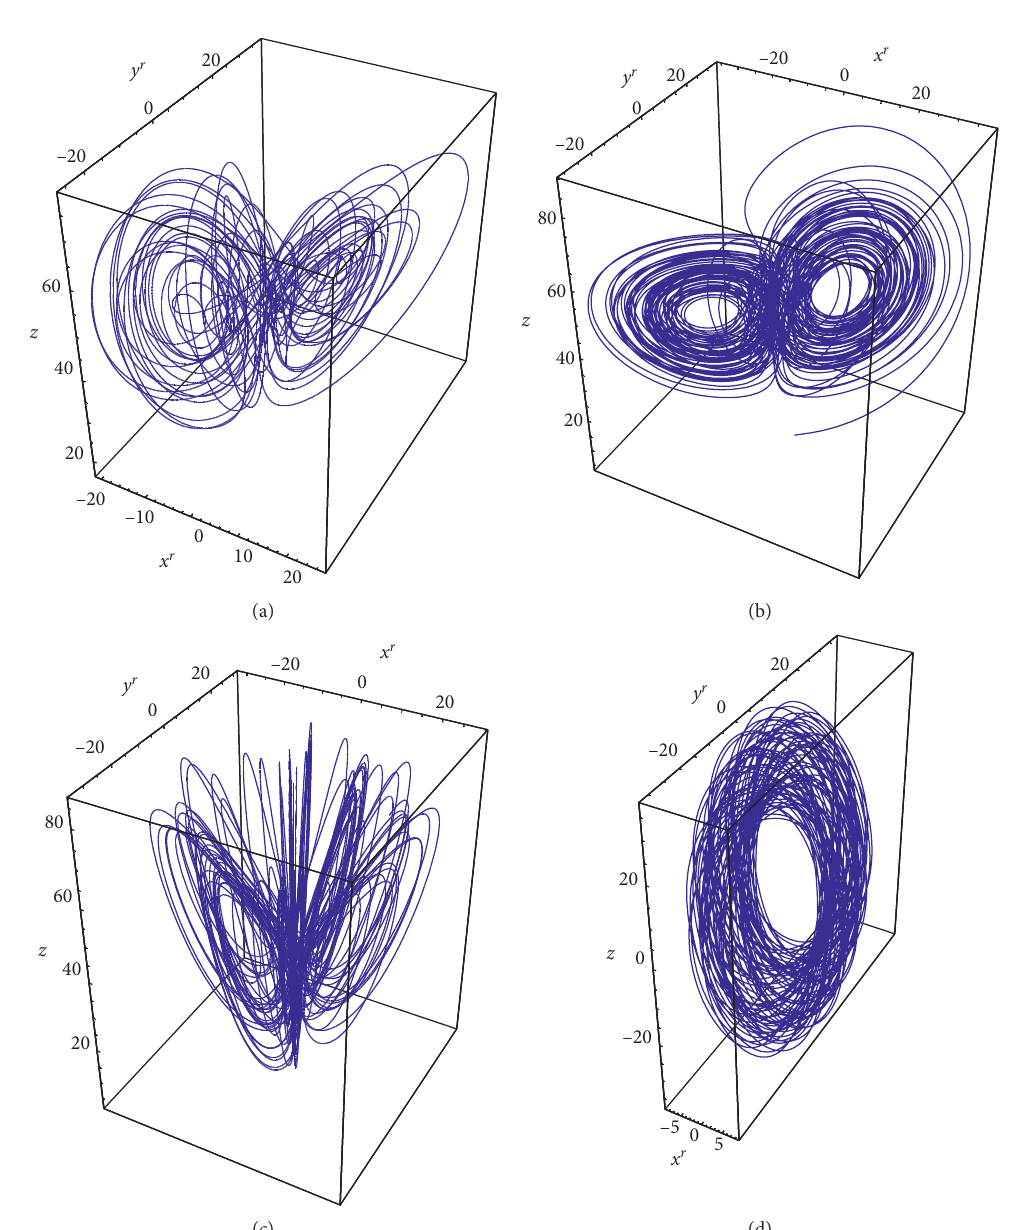
Figure 2: Clarifications of system (2) for b � 12 ,c � 20 , d � 3 , and h � 10 differ a including the primary positions in Figure 1. (a) Chaotic solution, a � 0 . 5, in ( z i ,x r , y r ) . (b) Hyperchaotic solution, a � 2 . 5, in ( z i , x r ,y r ) . (c) Quasiperiodic solution, a � 3 . 2, in ( z i , x r ,y r ) . (d) Quasiperiodic solutions, a � 15, in ( z i , x r ,y r )